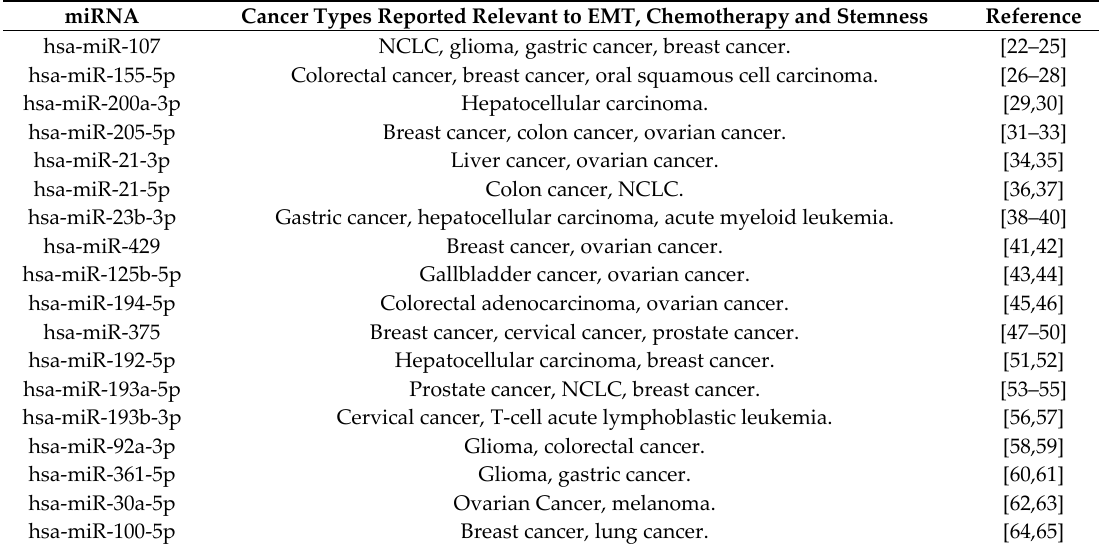
Table 2. Selected miRNA profile related to EMT, chemotherapy, and stemness in cancers. miRNA Cancer Types Reported Relevant to EMT, Chemotherapy and Stemness hsa ‐ miR ‐ 107 NCLC, glioma, gastric cancer, breast cancer. hsa ‐ miR ‐ 155 ‐ 5p Colorectal cancer, breast cancer, oral squamous cell carcinoma. hsa ‐ miR ‐ 200a ‐ 3p Hepatocellular carcinoma. hsa ‐ miR ‐ 205 ‐ 5p Breast cancer, colon cancer, ovarian cancer. hsa ‐ miR ‐ 21 ‐ 3p Liver cancer, ovarian cancer. hsa ‐ miR ‐ 21 ‐ 5p Colon cancer, NCLC. Gastric cancer, hepatocellular carcinoma, acute myeloid leukemia. hsa ‐ miR ‐ 429 Breast cancer, ovarian cancer. hsa ‐ miR ‐ 125b ‐ 5p Gallbladder cancer, ovarian cancer. hsa ‐ miR ‐ 194 ‐ 5p Colorectal adenocarcinoma, ovarian cancer. hsa ‐ miR ‐ 375 Breast cancer, cervical cancer, prostate cancer. hsa ‐ miR ‐ 192 ‐ 5p Hepatocellular carcinoma, breast cancer. hsa ‐ miR ‐ 193a ‐ 5p Prostate cancer, NCLC, breast cancer. hsa ‐ miR ‐ 193b ‐ 3p Cervical cancer, T ‐ cell acute lymphoblastic leukemia. hsa ‐ miR ‐ 92a ‐ 3p Glioma, colorectal cancer. Glioma, gastric cancer. Ovarian Cancer, melanoma. hsa ‐ miR ‐ 100 ‐ 5p Breast cancer, lung